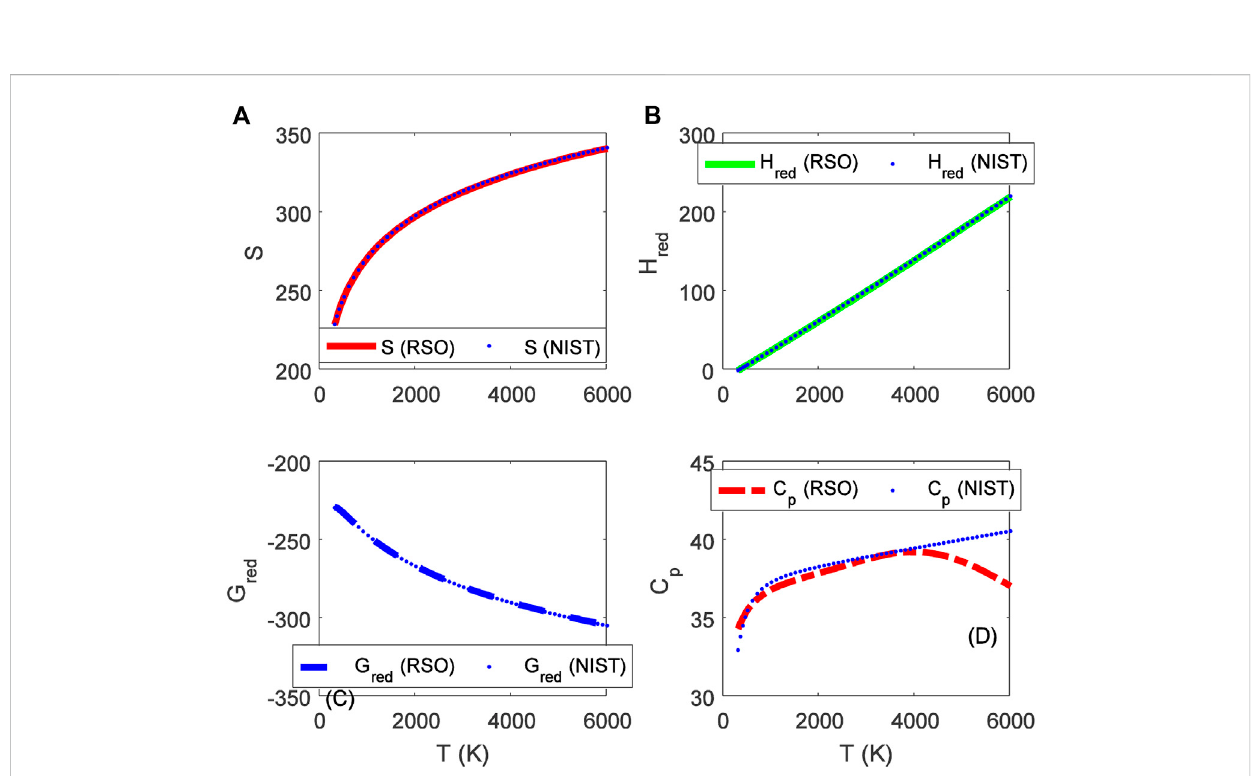
FIGURE 4 Variationof (A) molarentropy(J mol − 1 K − 1 ), (B) reducedenthalpy(kJ mol − 1 ), (C) reducedGibbsfreeenergy(J mol − 1 K − 1 ),and (D) isobaricspeci fi cheat capacity as a function of temperature for the ground state BrF (X 1 Σ + )